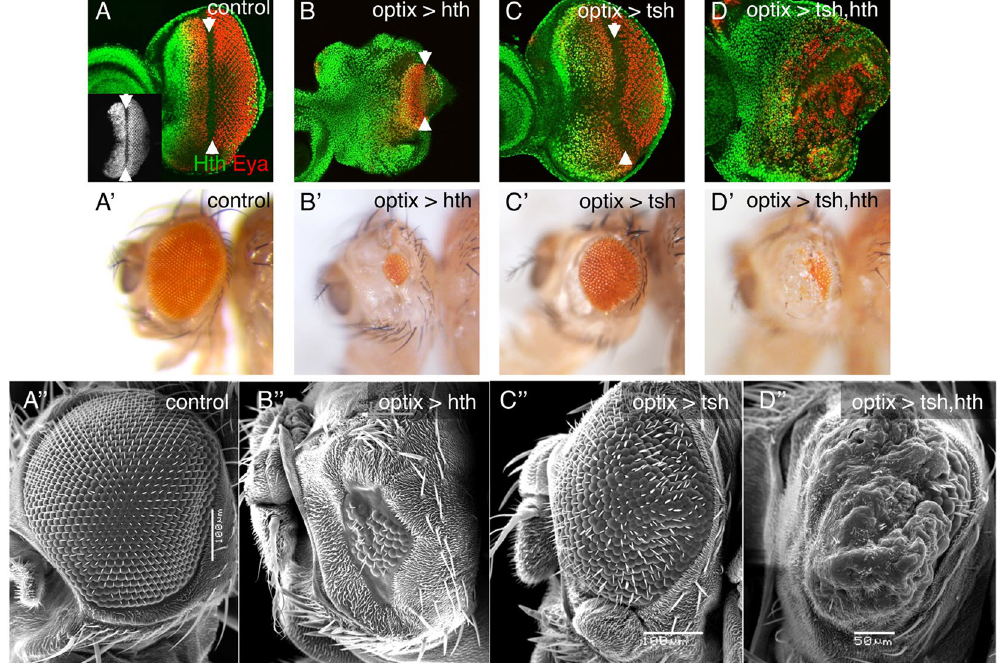
Figure 1. Forced maintenance of hth and tsh expression results in overgrowth and differentiation arrest. Late third instar (L3) eye discs ( A – D ) and adult heads ( A’ – D’ and A” – D” ) from control ( optix > GFP ) and hth- ( optix > hth ), tsh- ( optix > tsh ) or hth + tsh- ( optix > hth + tsh ) expressing animals. The GFP expression driven by optix > ( optix2 / 3 - GAL4 ; UAS - GFP ) is shown in the inset in ( A ). Discs are stained with anti-Eya and anti-Hth. Anterior is left, dorsal is up (this orientation will be maintained throughout). ( A’ – D’ ) Lateral views of adult heads of the same genotypes as above. ( A” – D” ) SEM images of lateral views of adult heads of the corresponding genotypes. Overexpression of hth ( optix > hth) results in a reduced eye disc area and smaller adult eye ( B , B” ). tsh -overexpressing flies ( optix > tsh) show almost normal discs and retinal morphology ( C – C” ). However, overexpression of hth and tsh ( optix > hth + tsh ), results in overgrown eye discs showing abnormal folds. Adult heads develop a small retinal patch and an overgrowth of indistinct cuticle ( D , D”